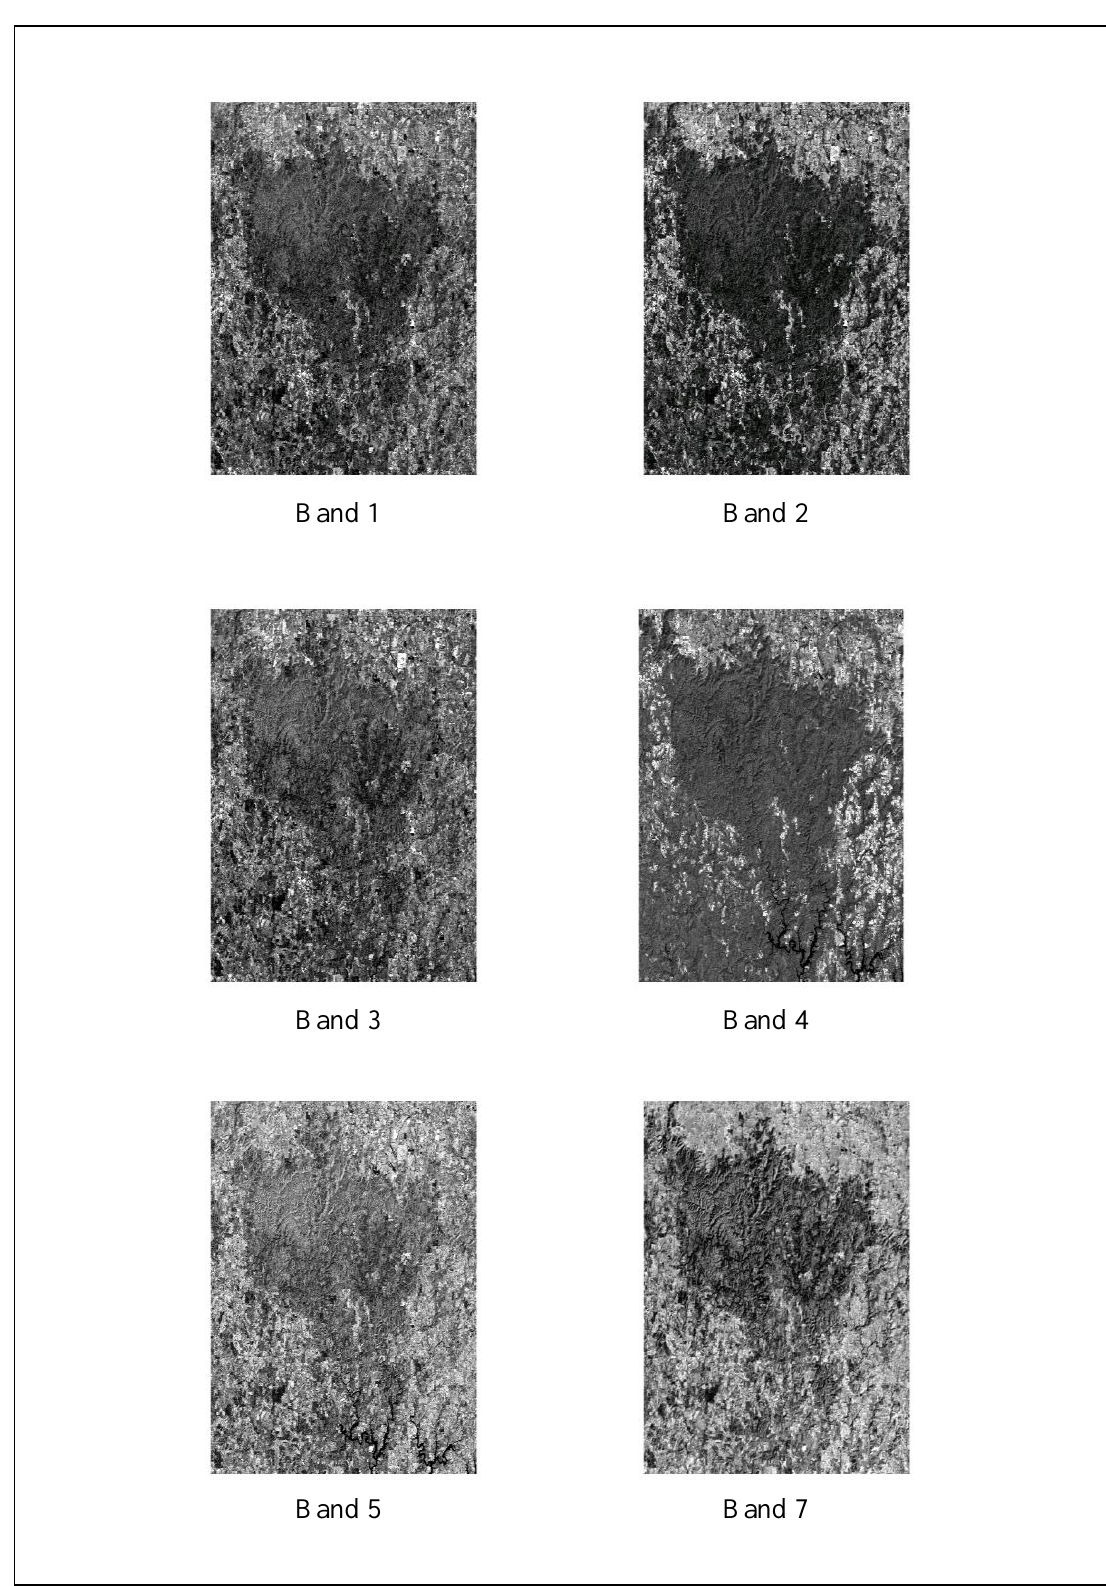
Figure 10. Multiple spectral images of Bankhead National Forest, AL,